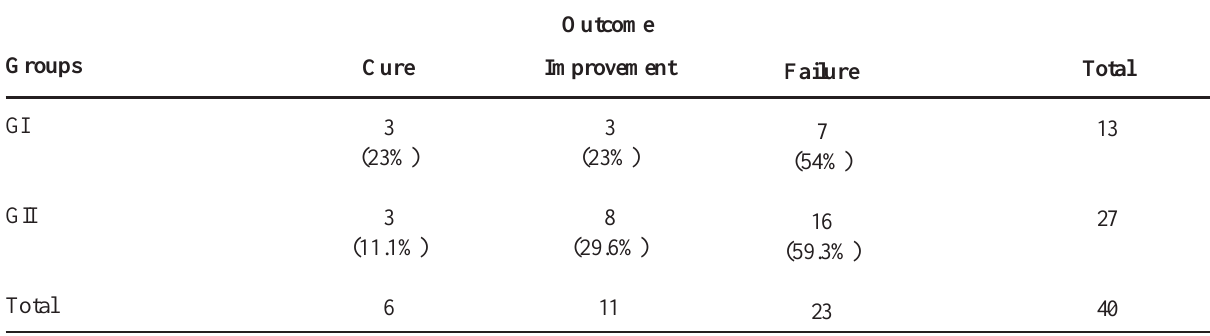
Table 1 – Cystometric evaluation in the different groups.